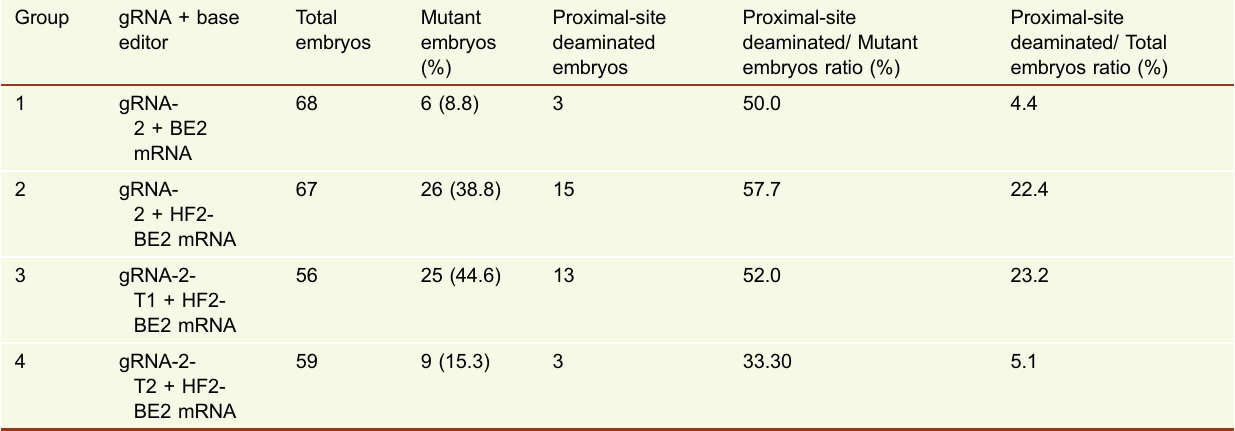
Table 2. Summary of base editing by HF2-BE2 and BE2 in mouse embryos